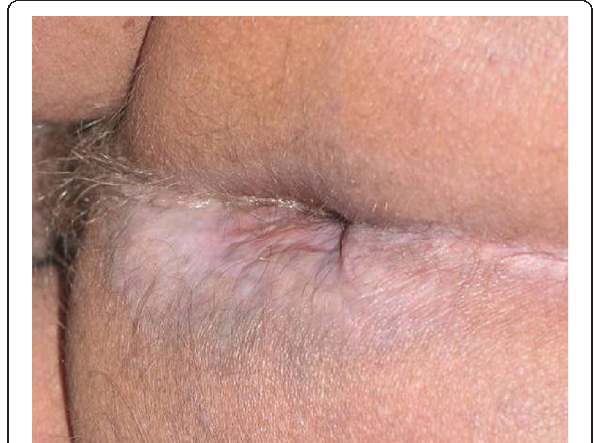
Figure 8 Perianal ulcer completely healed with antituberculous treatment for two